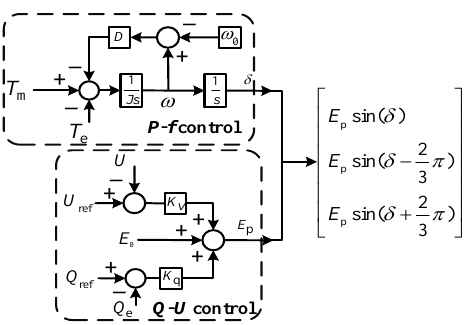
Figure 2. Typical virtual synchronous generator (VSG) control diagram.